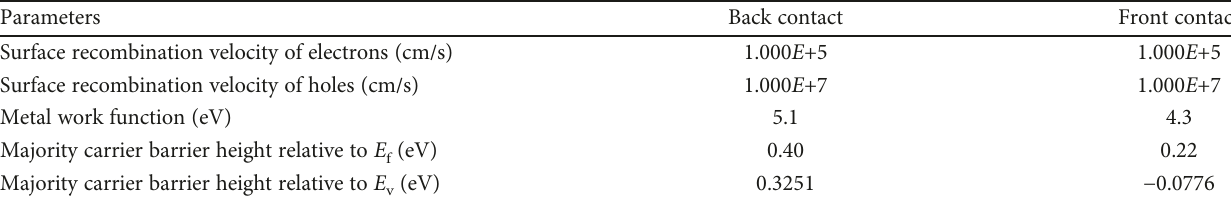
Table 3: Parameters for back and front contact.